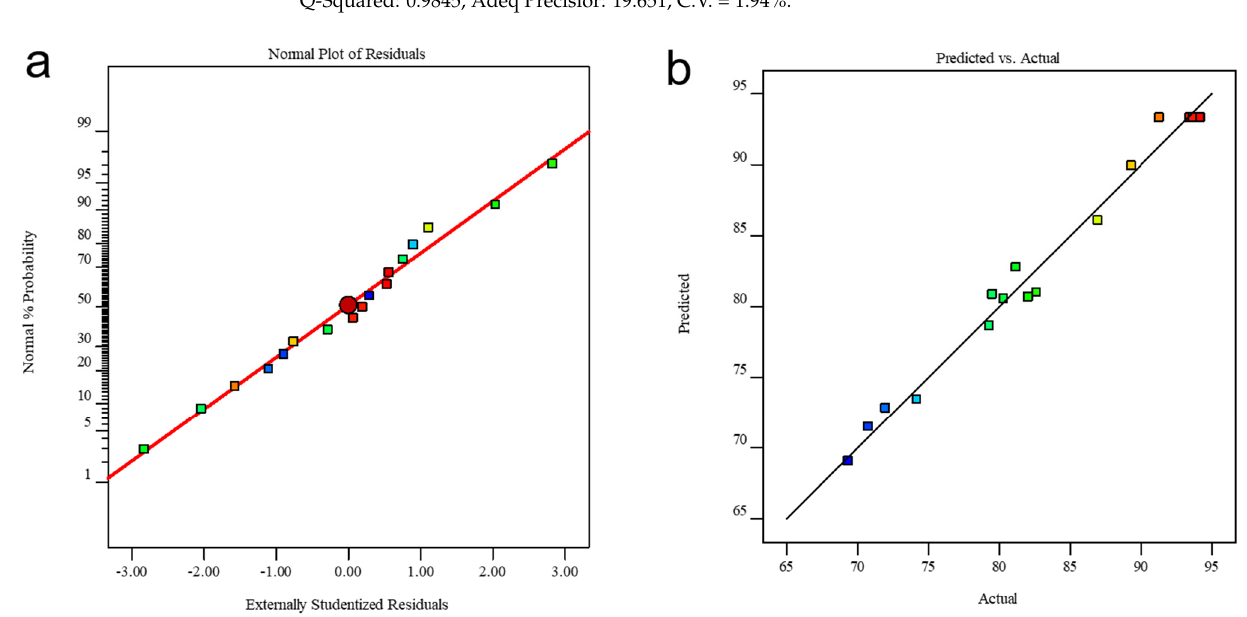
Figure 4. ( a ) The normal plot of residuals for Cr(VI) removal. ( b ) Plot of the actual and predicted response. The colors of points have no specific